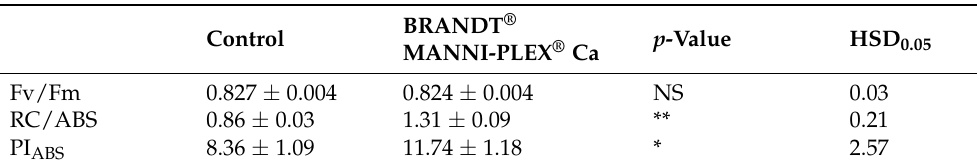
Table 1. Effect of BRANDT ® MANNI-PLEX ® Ca application on some parameters of Chl a fluorescence analyzed in leaves of pepper plants.